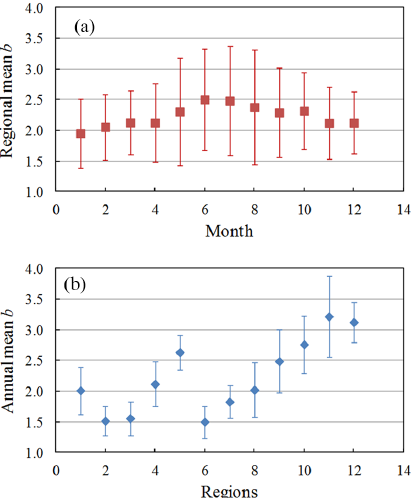
Figure 11. Regional and seasonal variations: (a) regionally aver- aged b values for each month with error bars ( ± 1 standard devi- ation) representing the regional variability; (b) annually averaged b values for each region with error bars representing the seasonal variability.